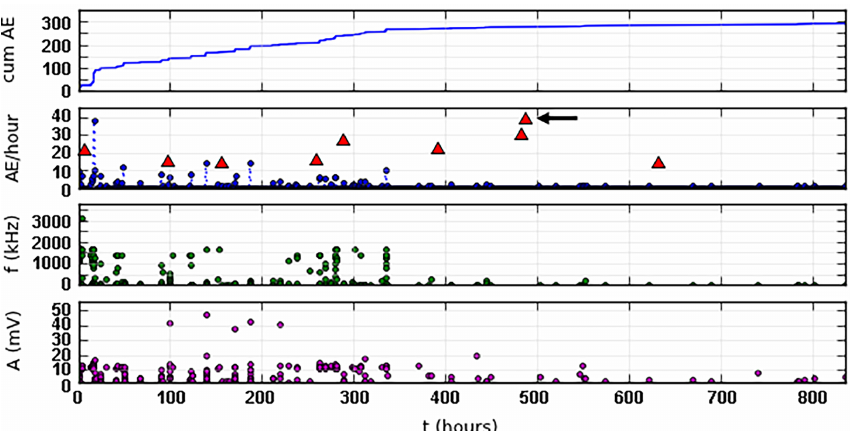
Figure 4. From top to bottom: accumulated number of AE signals (“hits”): the dashed line indicates a critical point revealed by the natural- time analysis; AE count rate and sequence of nearby earthquakes marked by red triangles (the arrow points to the strongest one); time series of signal frequencies and